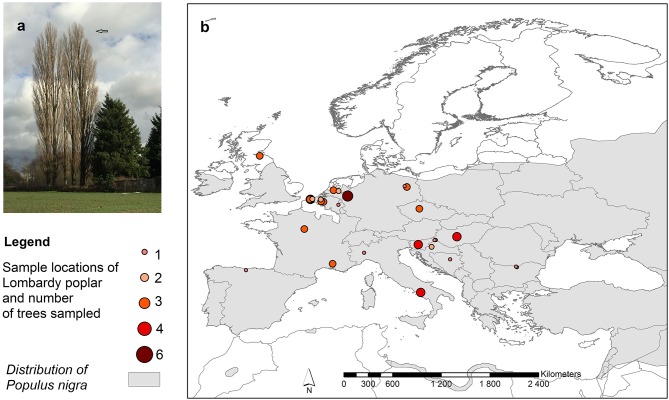
(a) Lombardy poplars, (b) Distribution of collection sites of Lombardy poplars and number of trees sampled per location. The map also shows the distribution range of the Populus nigra L. in Europe, including natural and naturalized stands (EUFORGEN http://www.euforgen.org/species/populus-nigra/).